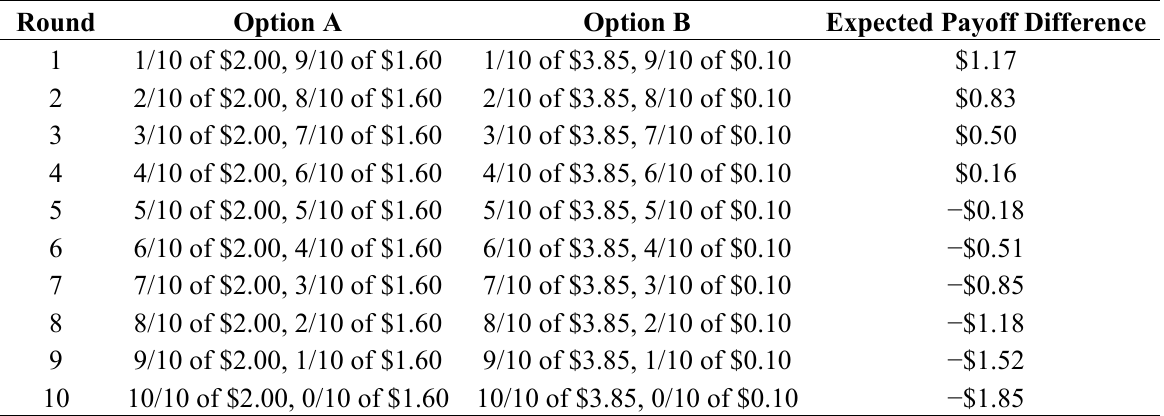
Table 1. Probabilities and payoffs for options in risk lottery